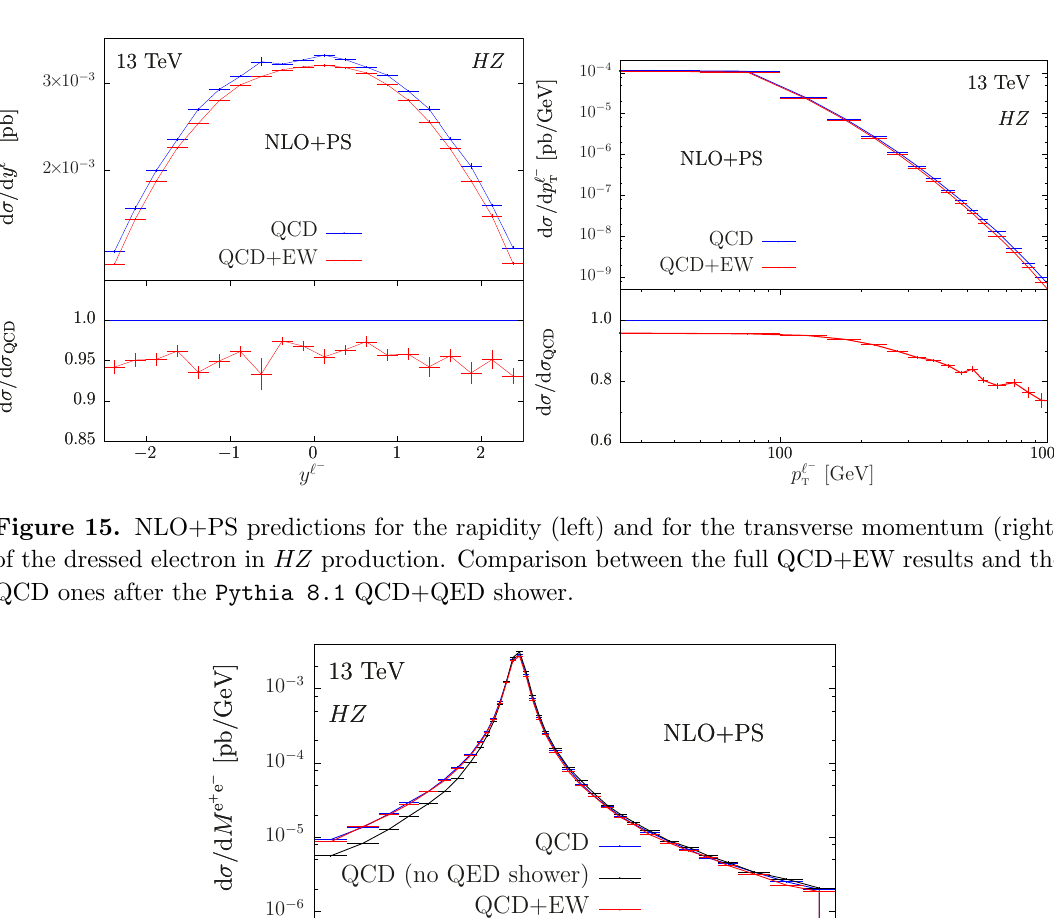
about 5% in the plotted rapidity range, while in the high-energy tail of the p (cid:0) the EW corrections decrease the di(cid:11)erential cross section by roughly 30% due to Sudakov